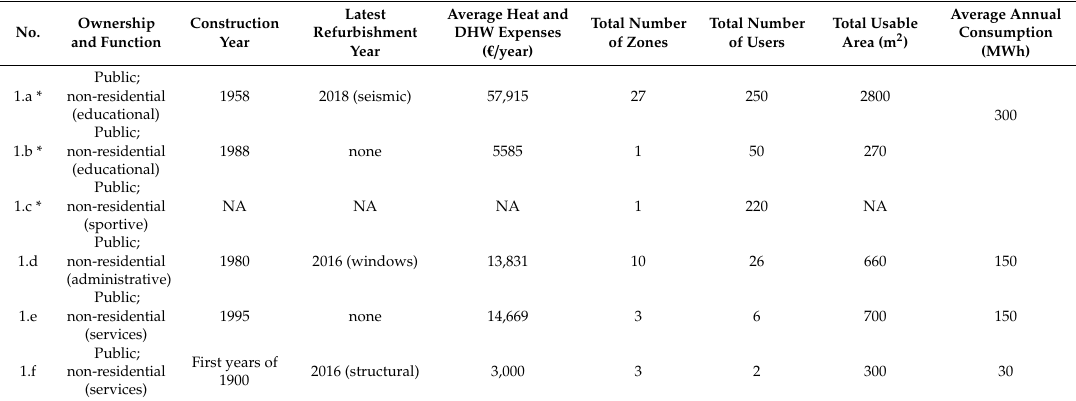
Table 2. Oulx data and information collection.